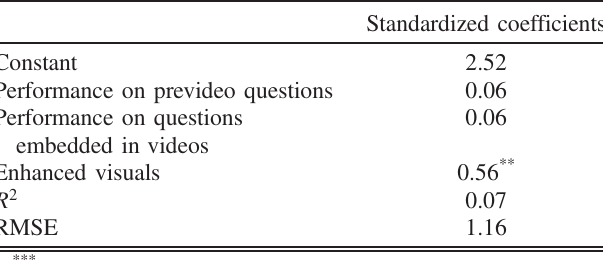
TABLE II. Standardized coefficients for linear regression models predicting students ’ postvideo performance based on their performance on the questions embedded throughout the video (controlling for performance on prevideo questions and inclusion of enhanced